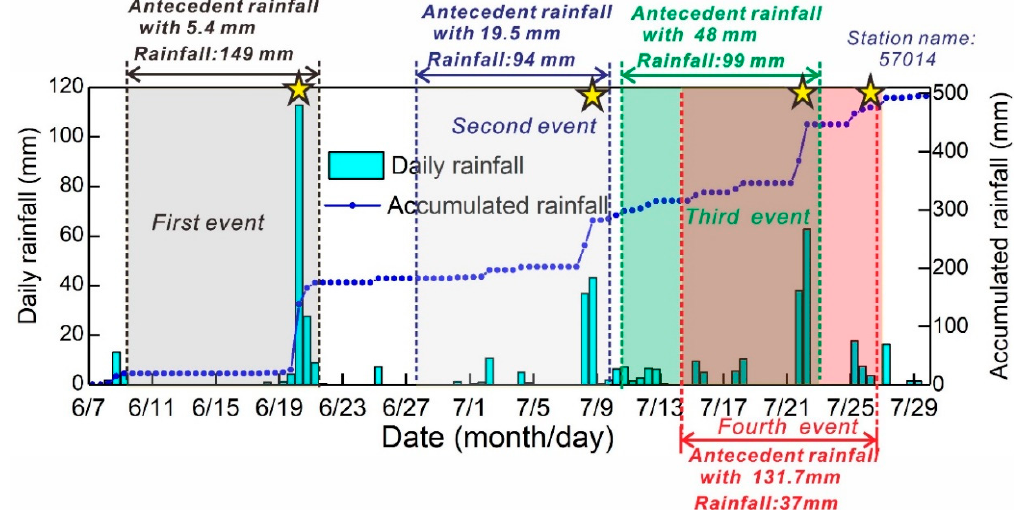
Figure 5. Rainfall data for every 12 h from June to July at rainfall station 57,014 in the study area.